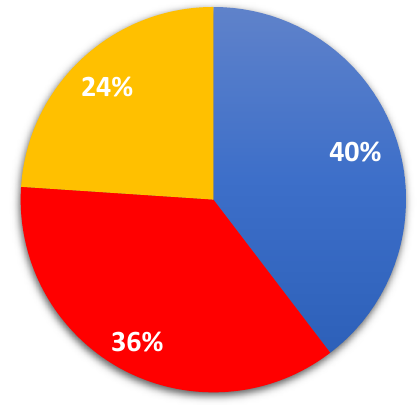
Figure 7. Steps to take in case of a denial-of-service attack. Source: Author’s